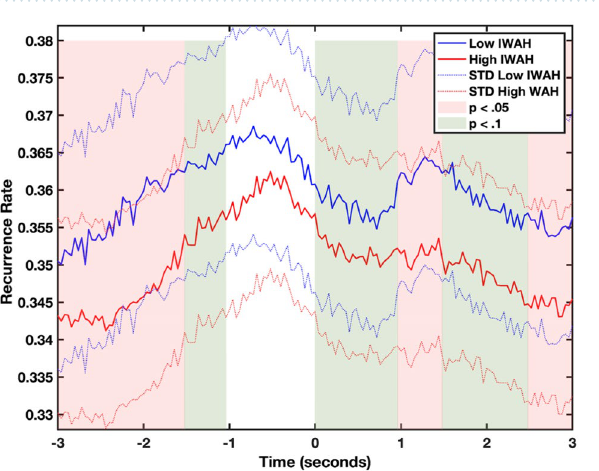
Figure 2. Average lag profiles between a participant and a lab assistant computed using diagonal-wise CRQA for the high-IWAH ( a ) and the low-IWAH ( b ) groups. The light red and light blue lines represent the standard deviation of mean normal and shuffled profiles, respectively. The red shaded area represents the time window where significant differences were found between the original (blue), and control shuffled profiles (red), while the green indicates areas reaching significance (trends). Recurrence rate values are normalized between 0 and 1.